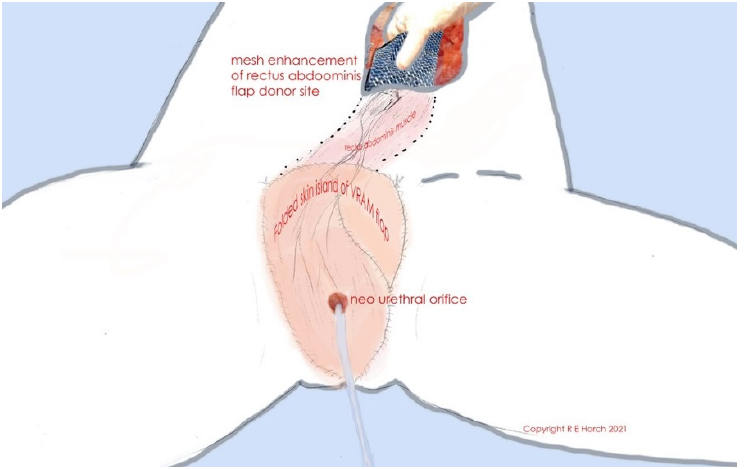
Figure 1. Schematic illustration of folded skin island of VRAM flap and neourethral orifice as well as of rectus abdominis muscle, tunneled subcutaneously. The flap donor site is closed with alloplastic mesh.